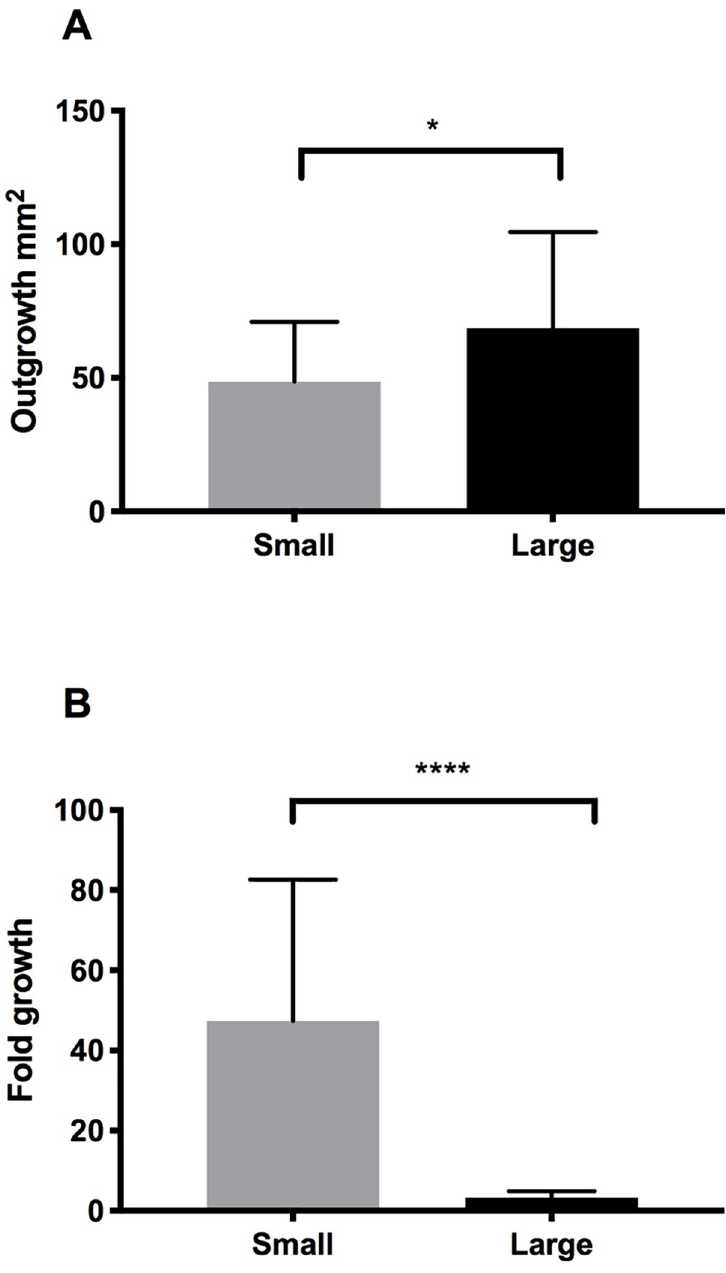
Fig 4. Outgrowth. Bar charts demonstrating the outgrowth (A) and fold growth (B) of LEC from small and large explants. � P < 0.01. Error bars represent the standard deviation of mean values. cells from the large explant group and 73.5 ± 15.2% of the cells in the small explant group stained positively for connexin 43 in the cell membranes (N = 26, P = 0.98, Fig 8C, panel 2, S2 and S3 Tables). Also for adherence junction marker E-cadherin that indicates differentiated type of cells[44, 45] (Fig 8A and 8B, panel 3, S2 and S3 Tables), staining of cell membranes were found in 95.4 ± 2.7% cells in LEC derived from large explants and 93.1 ± 4.6% for cells derived from small explants (N = 25, P = 0.13, Fig 8C, panel 3, S2 and S3 Tables).